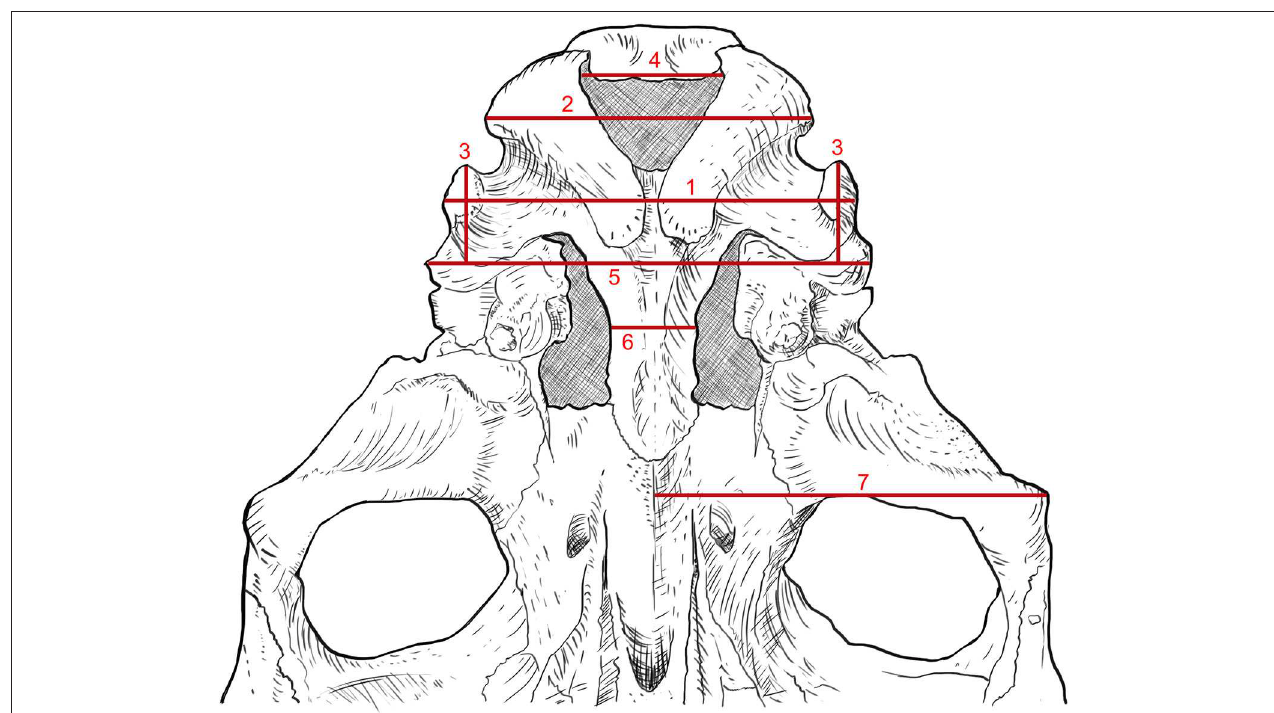
FIGURE 2 | Measurements of the basicranium of equid species. 1. Width across jugal processes. 2. Width of occipital condyles. 3. Width of jugal apophyses. 4 width of foramen magnum. 5. Width across mastoid processes. 6. Minimum width of the basilar process. 7. Width across middle line of basisphenoid to the temporal articular